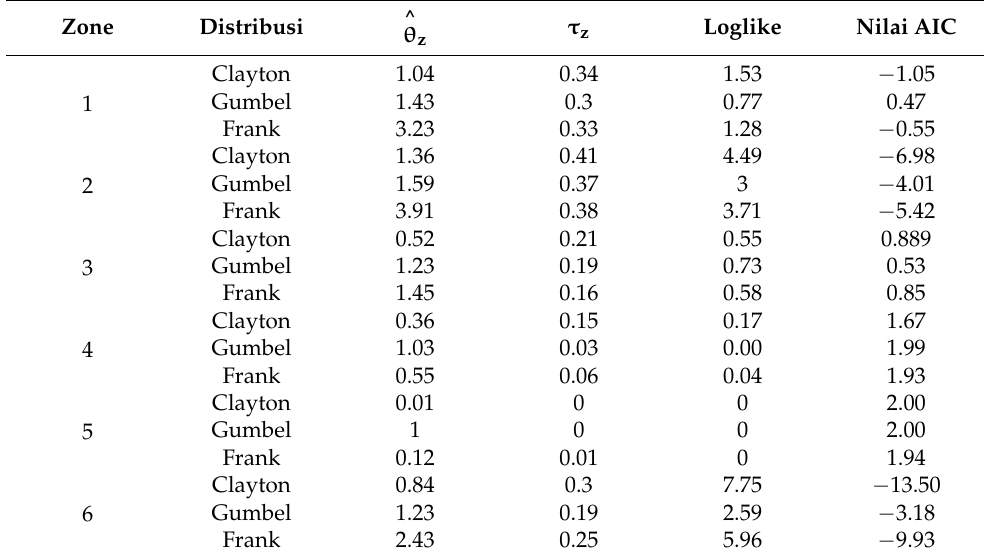
Table 17. Parameter estimation results and AIC values in Cluster Type II.